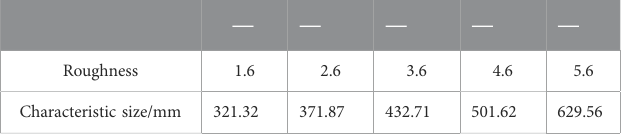
TABLE 10 Characteristic size of bulk modulus.